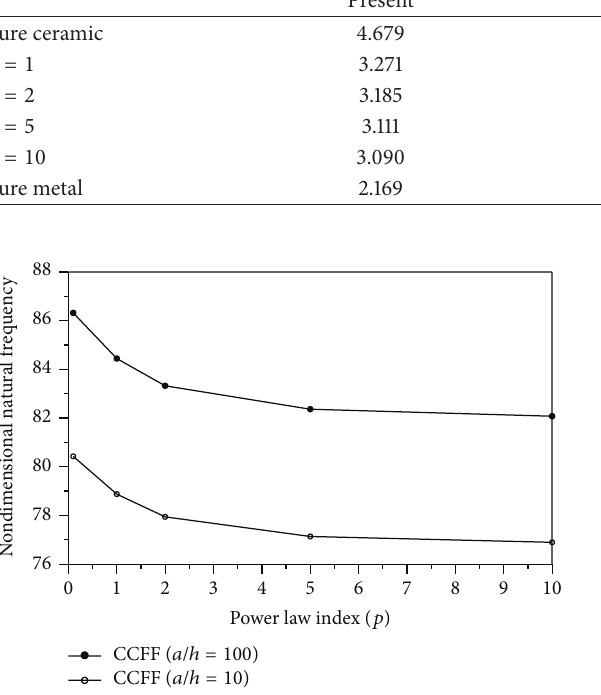
Figure 9: Buckling load of FGM plates: combined compressive, tensile, and shear